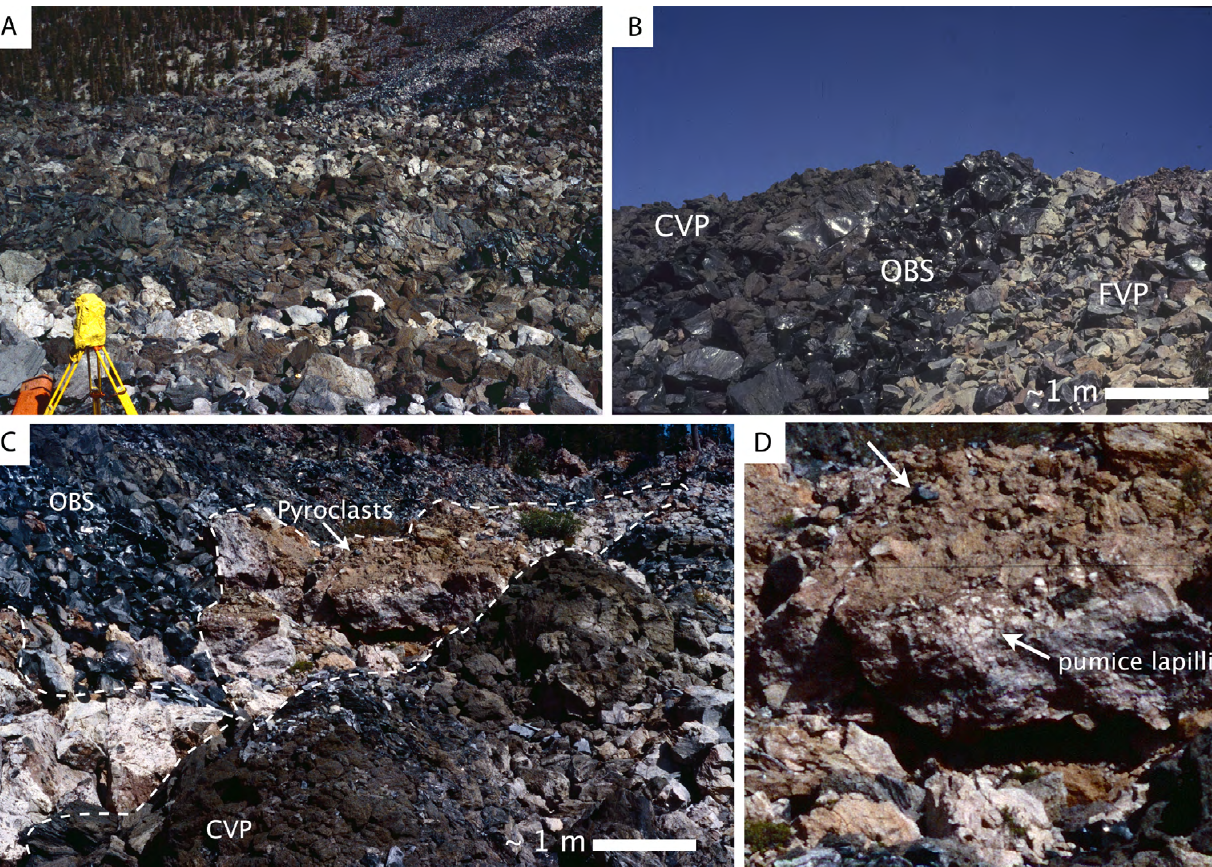
Figure 2: [Previous page] [A] NAIP (National Agriculture Imagery Program) satellite image of Big Glass Moun- tain. Breccia zones are highlighted by color enhancement in the lower left and upper right to distinguish them from “normal” flow top lava textures. Frames [B] and [C–E], correspond to field photographs of the boxed in ar- eas in frame [A]. These views show breccia zones [C] comprising meter-scale massive red breccia, pumice and obsidian bombs [D], and ash-rich polymictic breccia fragments [D]. Some breccia zones contain massive obsidian blocks interwoven with channels containing unconsolidated pyroclasts [E]. Such features may represent mega- tuffisites that were actively venting as lava effused from the vent [e.g. Castro et al. 2014]. Frames [F] and [G] show representative welding textures in breccia blocks that most likely underwent intense shear deformation during em- placement of the lava flow. That fragments as small as a centimeter are re-expanded through vesiculation (see rounded clasts in frame [F]) and also densely welded [G] indicates that pyroclasts retained significant heat and H O during the process of post-fragmentation welding. In the most densely welded case, breccia has a eutaxitic 2 foliation like that found in welded tuffs. Such textures—not found in “normal” flow top breccia—indicate that little if any time elapsed between the explosive activity that made the breccias and lava emplacement that swept them away.